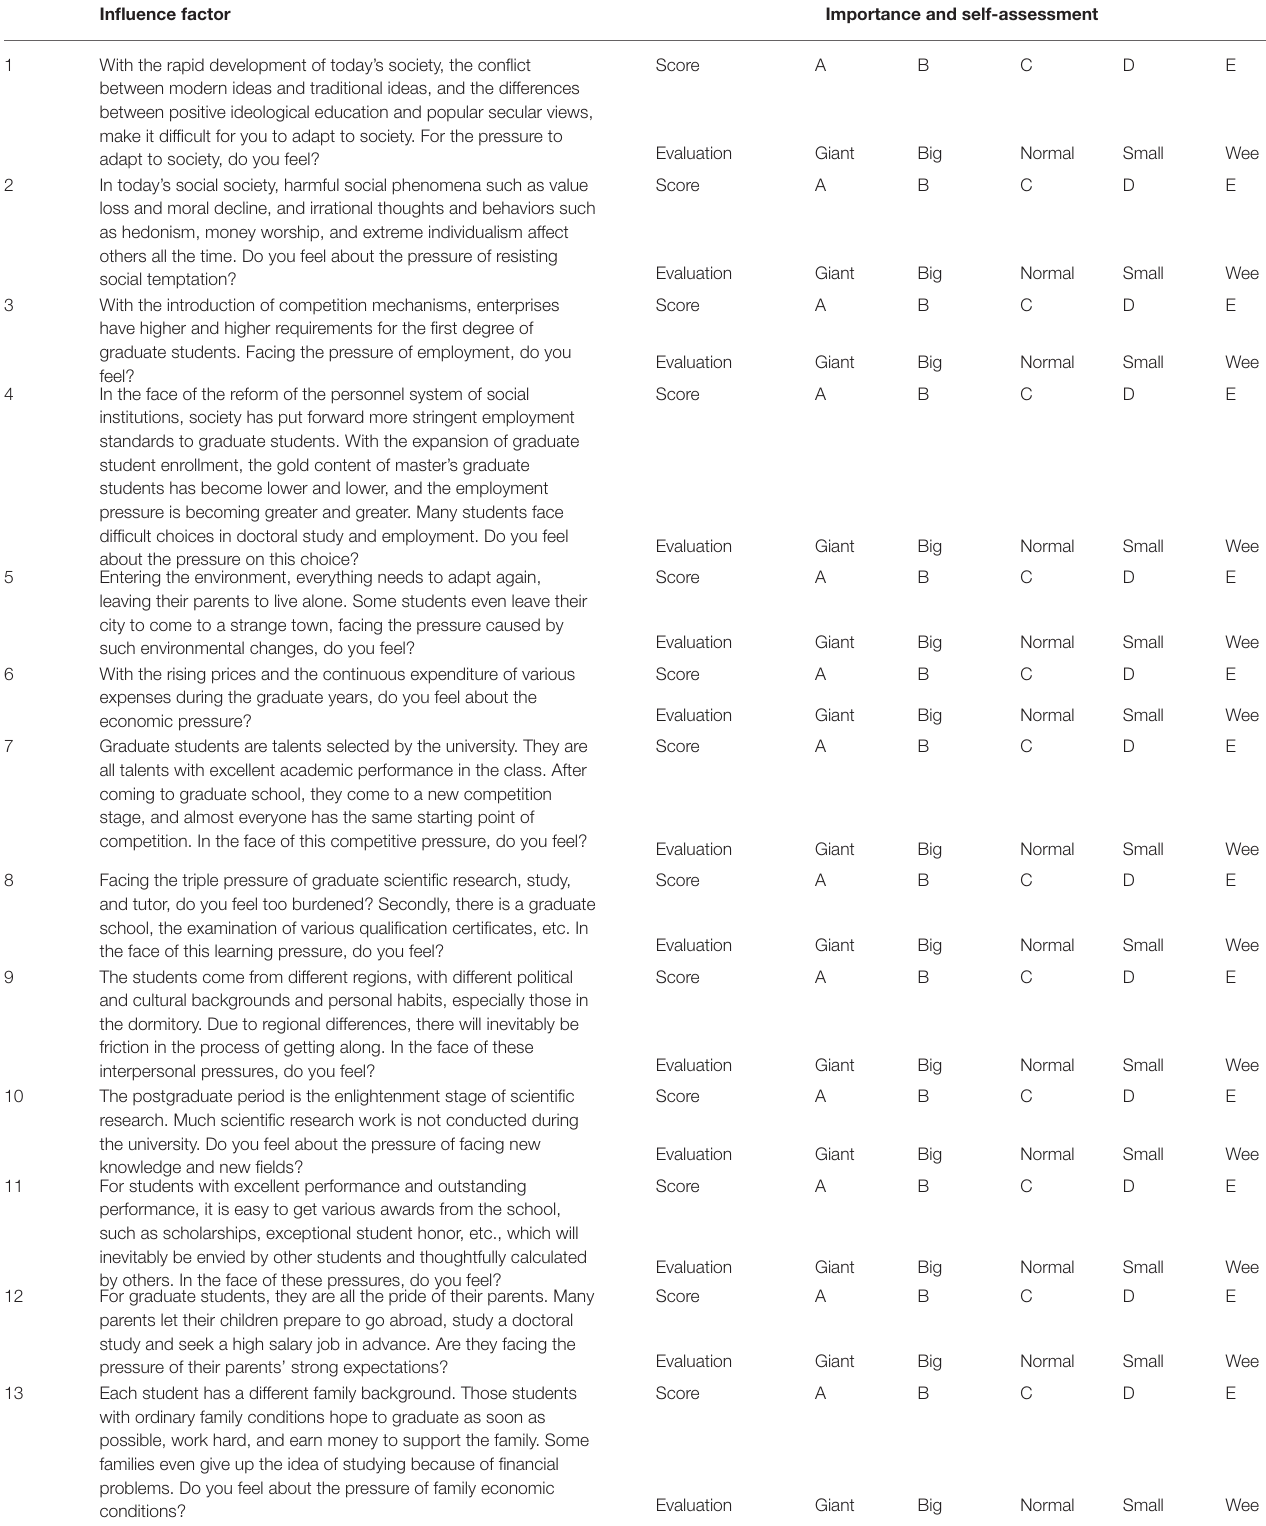
TABLE 1 | Main contents of the